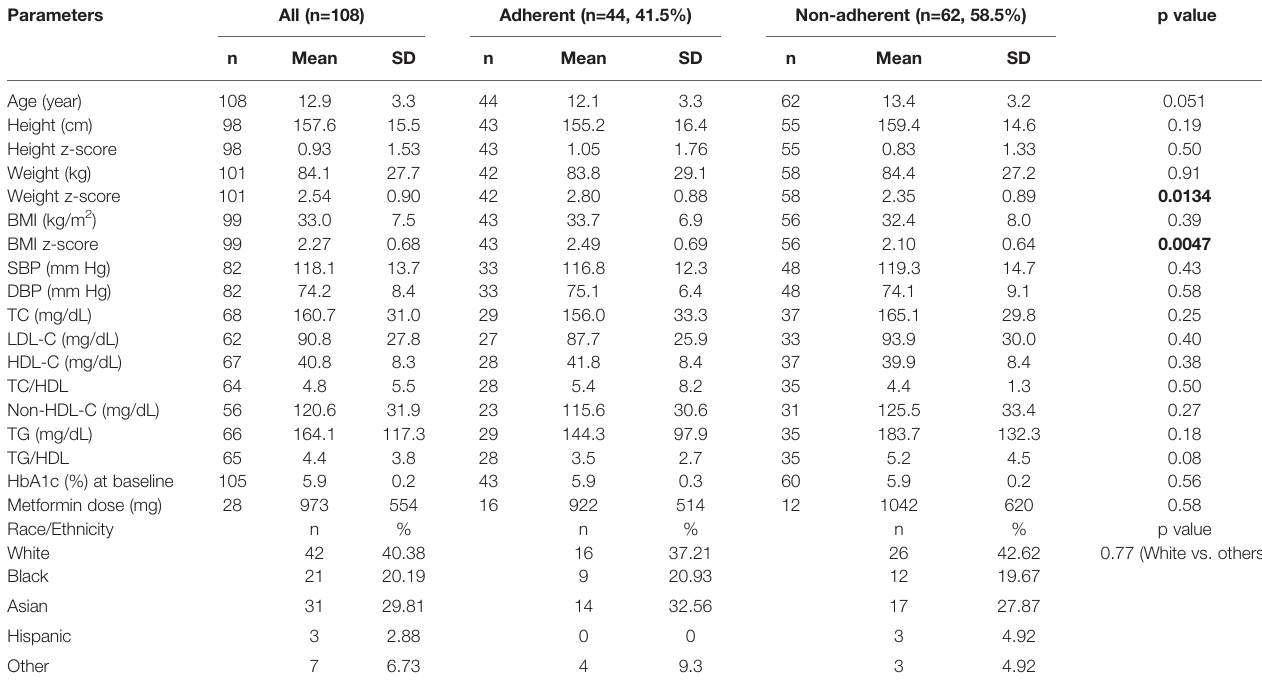
Agemin=3.8,max=21years.Twosubjectslackednutritionvisitinformation.Thus,therewere44adherentsubjectsand62non-adherentsubjects.p-valuewasobtainedfromtwosample t-test if variances were equal for p>=0.2; from Satterthwaite test if variances were not equal for p<0.2; or Chi-square test for categorical variable. Signi fi cant p values are